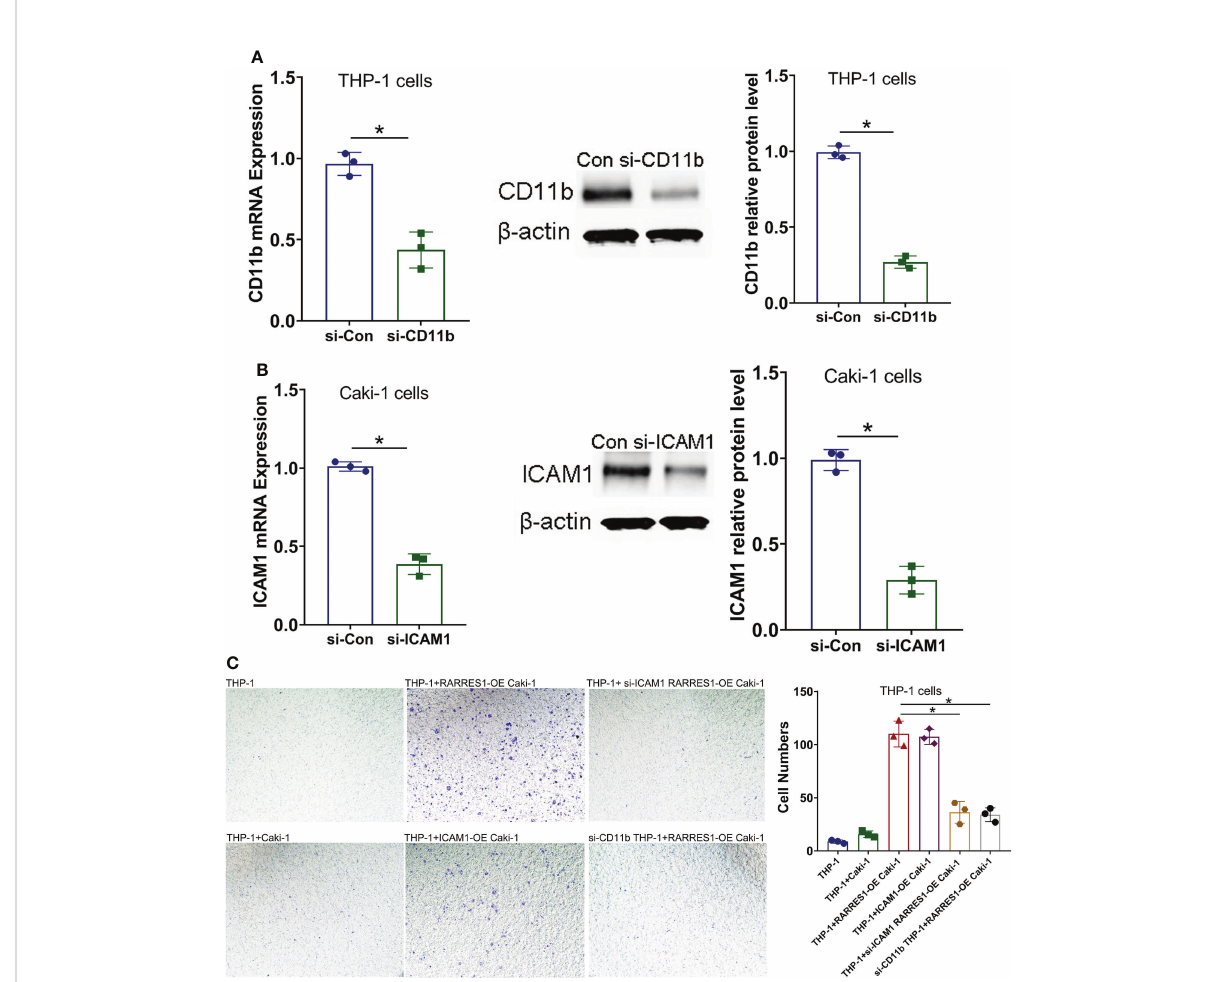
FIGURE 8 Blockade of Mac-1 or ICAM1 decreases the migration potential of macrophages. (A, B) The effects of siRNA transfection on Mac-1 (CD11b) and ICAM1 silencing were con fi rmed by qPCR and Western blot analysis. (C) Blockade of Mac-1 (CD11b) in macrophages or ICAM1 in RCC cells decreased RARRES1-OE-induced macrophage migration. The migration potential of macrophages (THP-1 cells) cocultured with renal carcinoma cells (Caki-1) was examined using a Transwell assay (scale bars: 100 m m). *p < 0.05.